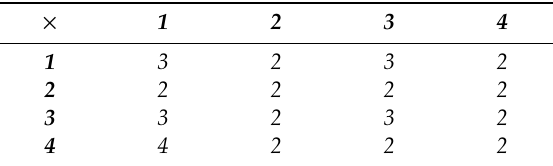
Table 8. The operation × on S .